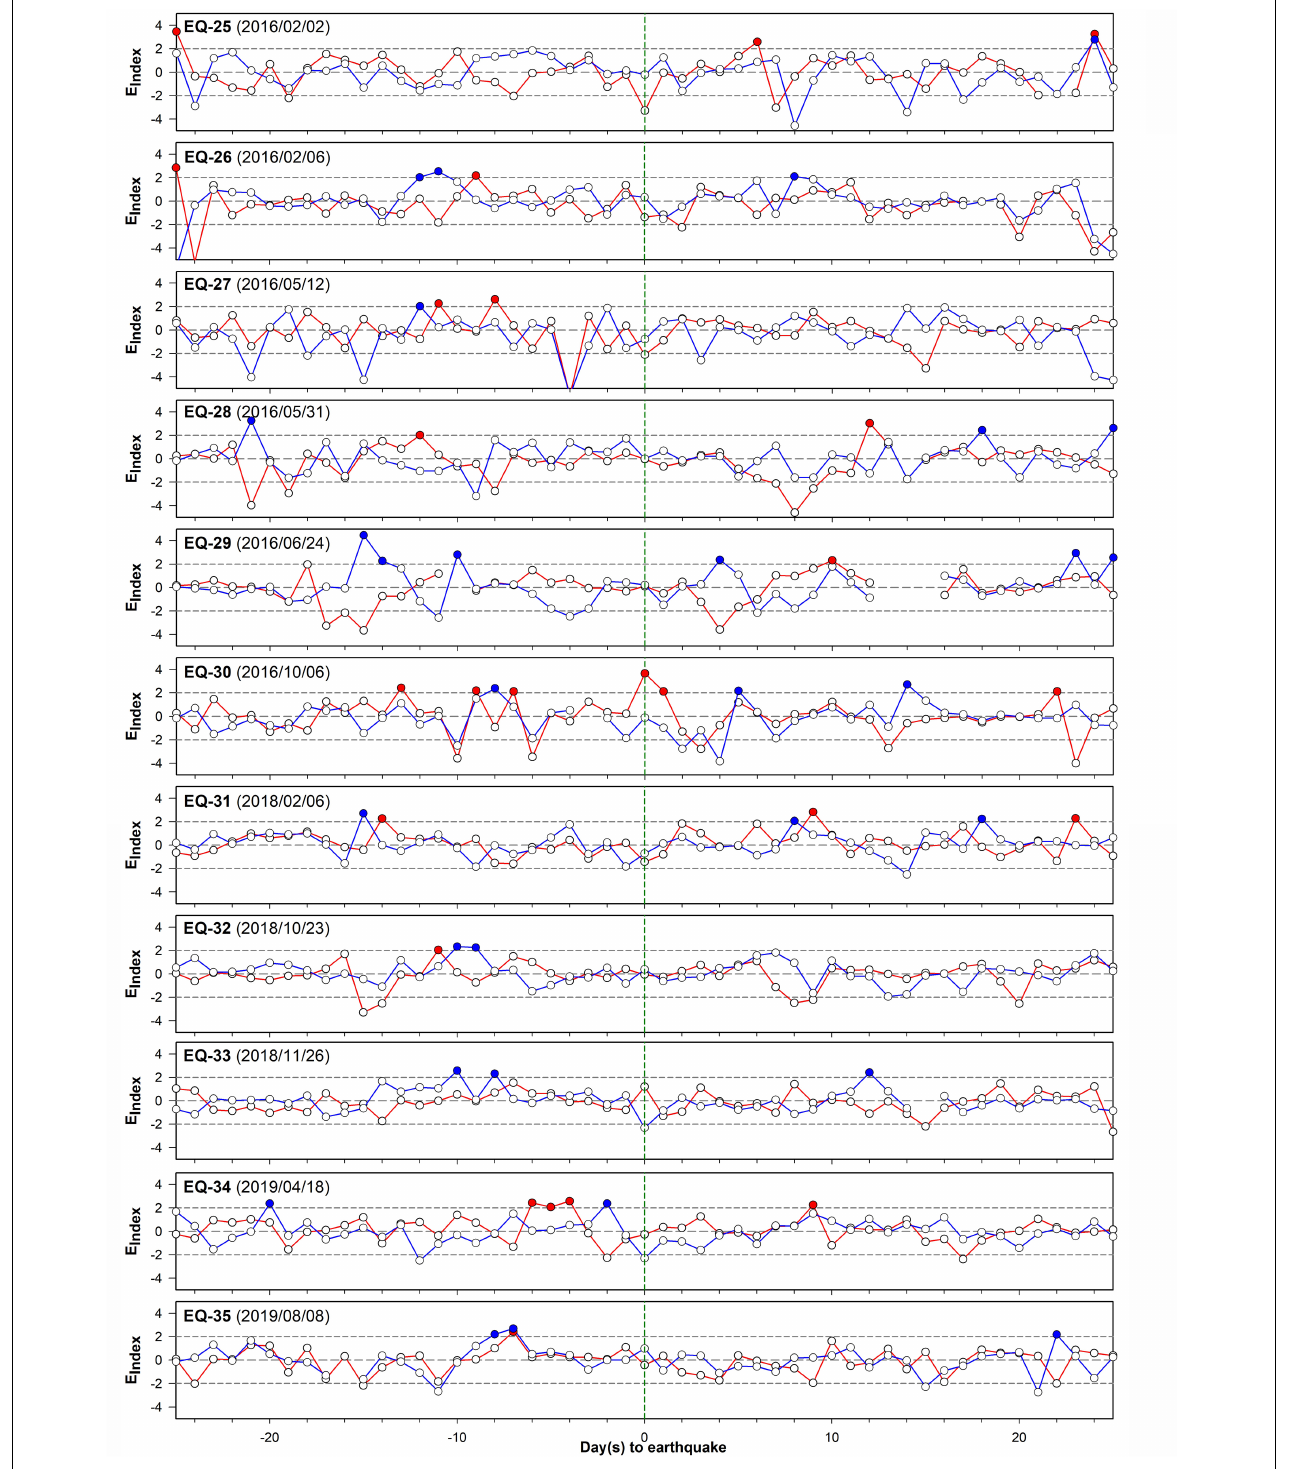
FIGURE 3 | Time-series of daily OLR E Index values associated with M ≥ 6 earthquakes over the epicenter area from 2009 to 2019 around Taiwan. The red and blue lines indicate the daily E Index variations in the daytime and nighttime, respectively, within 25 days before and after the earthquake. The earthquake’s anomalous days are considered to be when the increasing E Index value is greater than the threshold value ( E Index ≥ 2), as given by the red and blue dots. The occurrence of an earthquake is marked with the green dashed line. The shaded region indicates typhoon period. The relevant earthquakes are marked by the numbers shown in Figure 1 and listed in Table 1